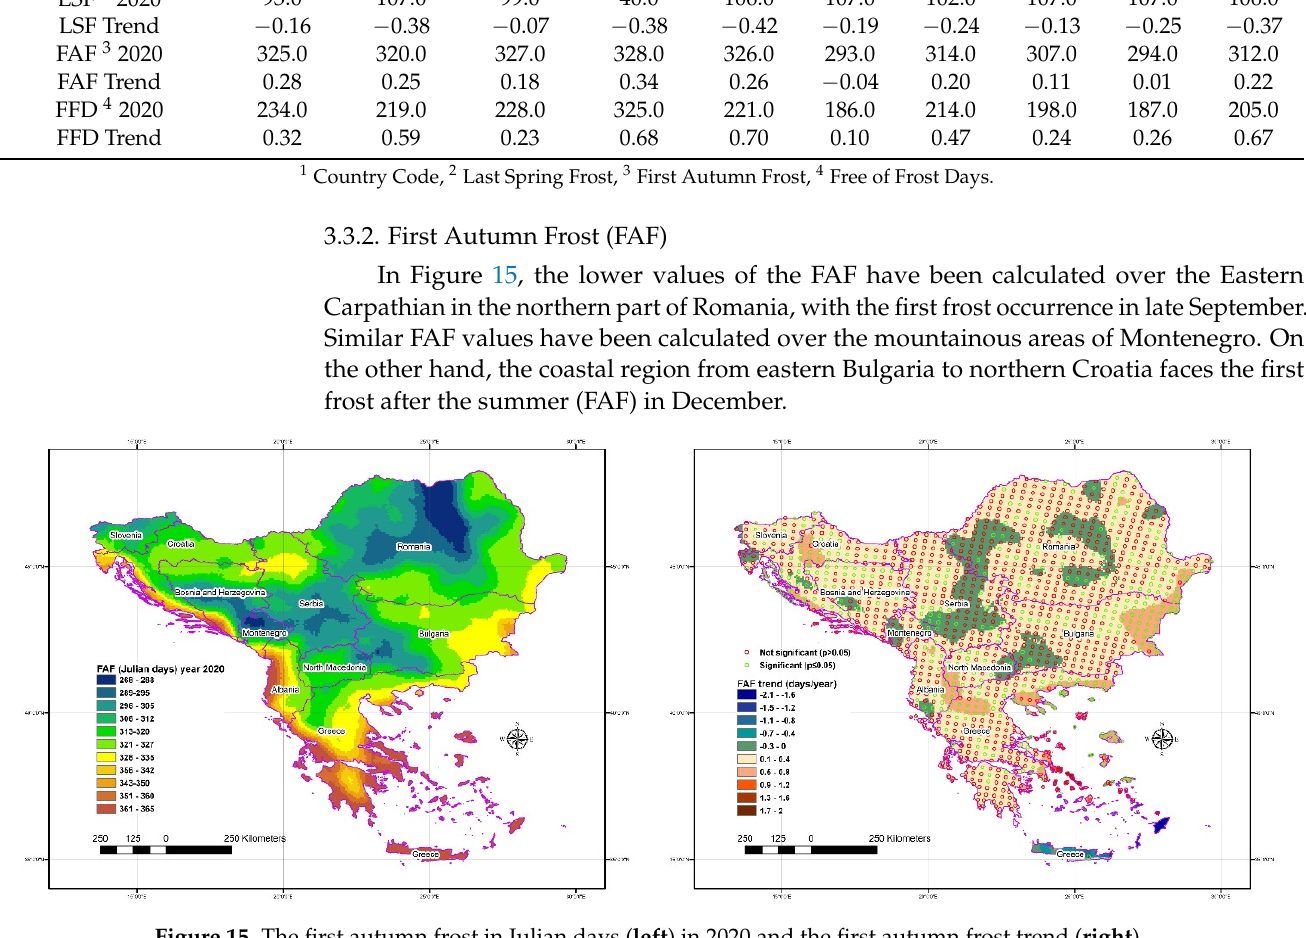
Figure 15. The first autumn frost in Julian days ( left ) in 2020 and the first autumn frost trend ( right ).